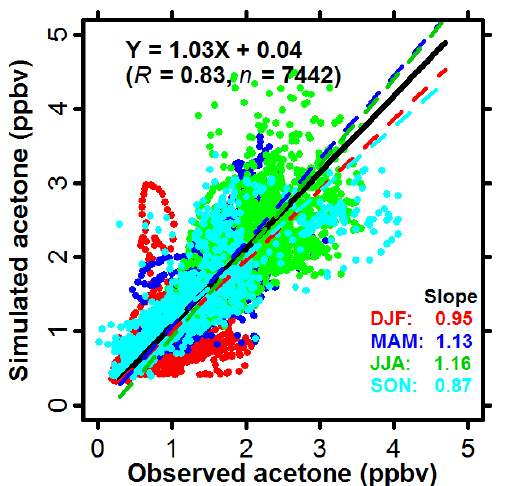
Fig. 5. Atmospheric acetone mixing ratios from the optimized Figure 5. Atmospheric acetone mixing ratios from the optimized GEOS-Chem simulation 3 GEOS-Chem simulation compared to observations at the KCMP compared to observations at the KCMP tall tower in 2010, colored by season. Data points are 1 h 4 mean values. 5 tall tower in 2010, colored by season. Data points are 1h mean val-